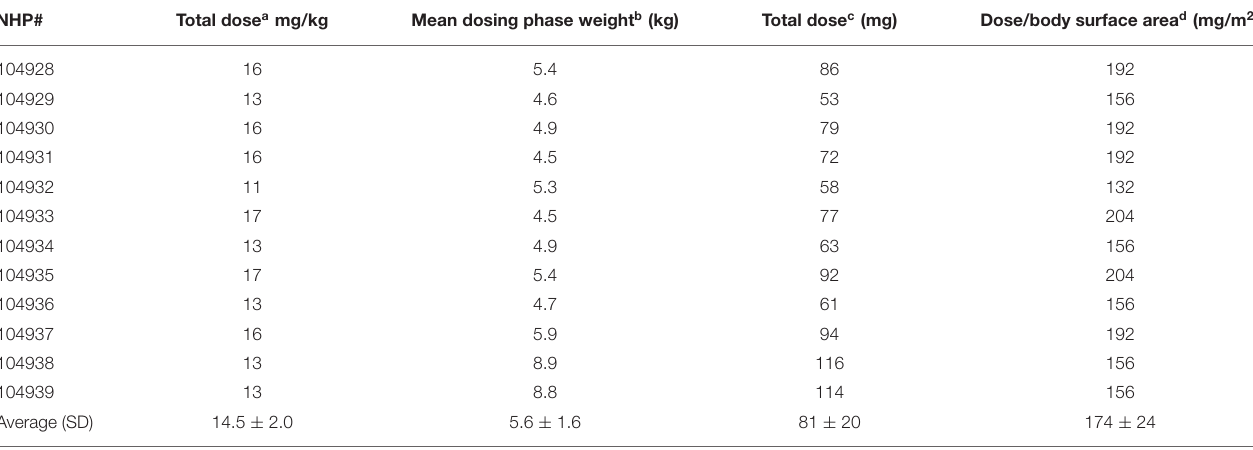
TABLE 2 | Cumulative dose estimation for each animal treated with doxorubicin.